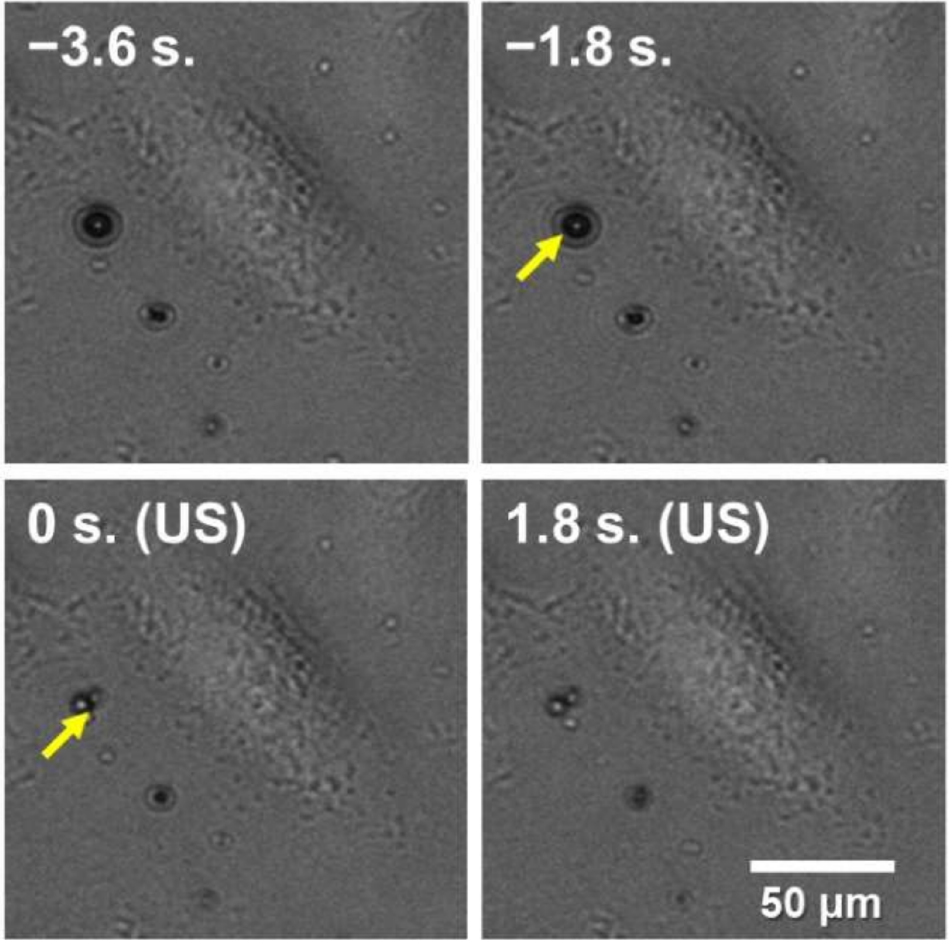
Figure 2. Brightfield images of a cavitation of microbubbles attached to a membrane of a cervical cancer cell. When comparing brightfield images before (t = − 1.8 s.) and immediately after (t = 0.0 s.) ultrasound exposures, it was observed that the size of the microbubble (indicated by a yellow arrow) was reduced due to the ultrasound-microbubble